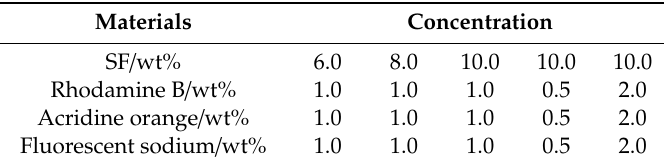
Table 1. Ratios of SF and fluorescent agents in spinning solution.